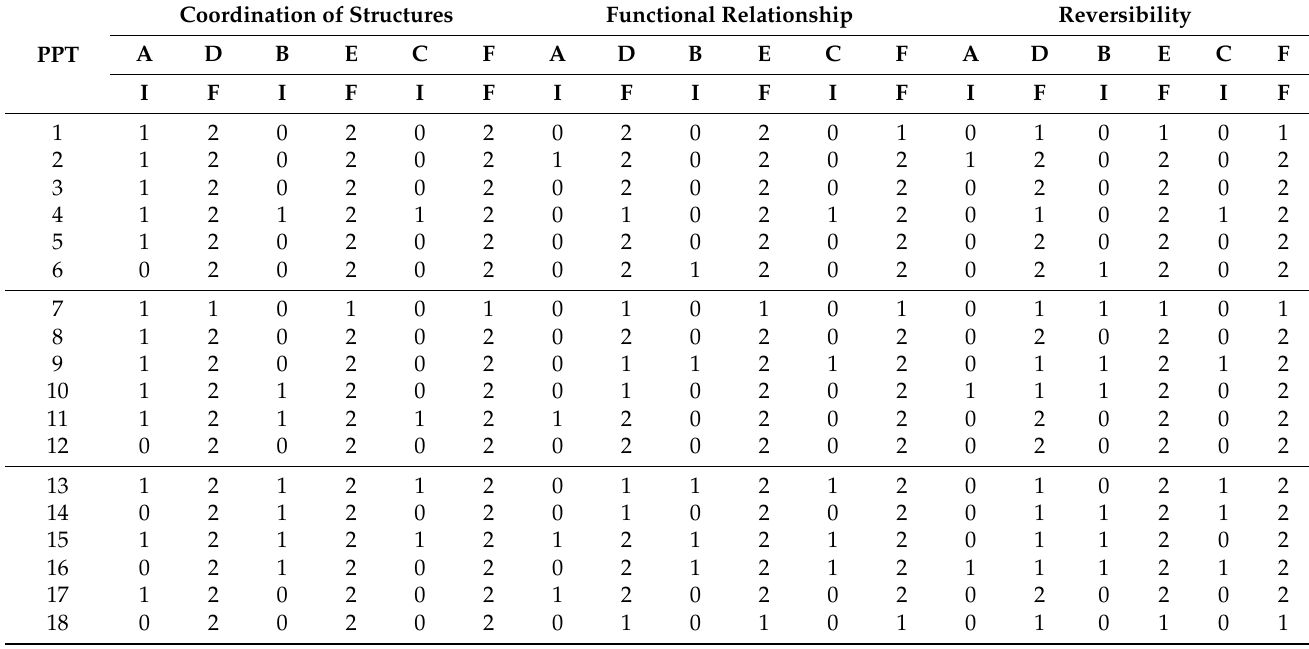
Table 5. PPT levels in the identification and use of mathematical elements. Coordination of Structures Functional Relationship PPT